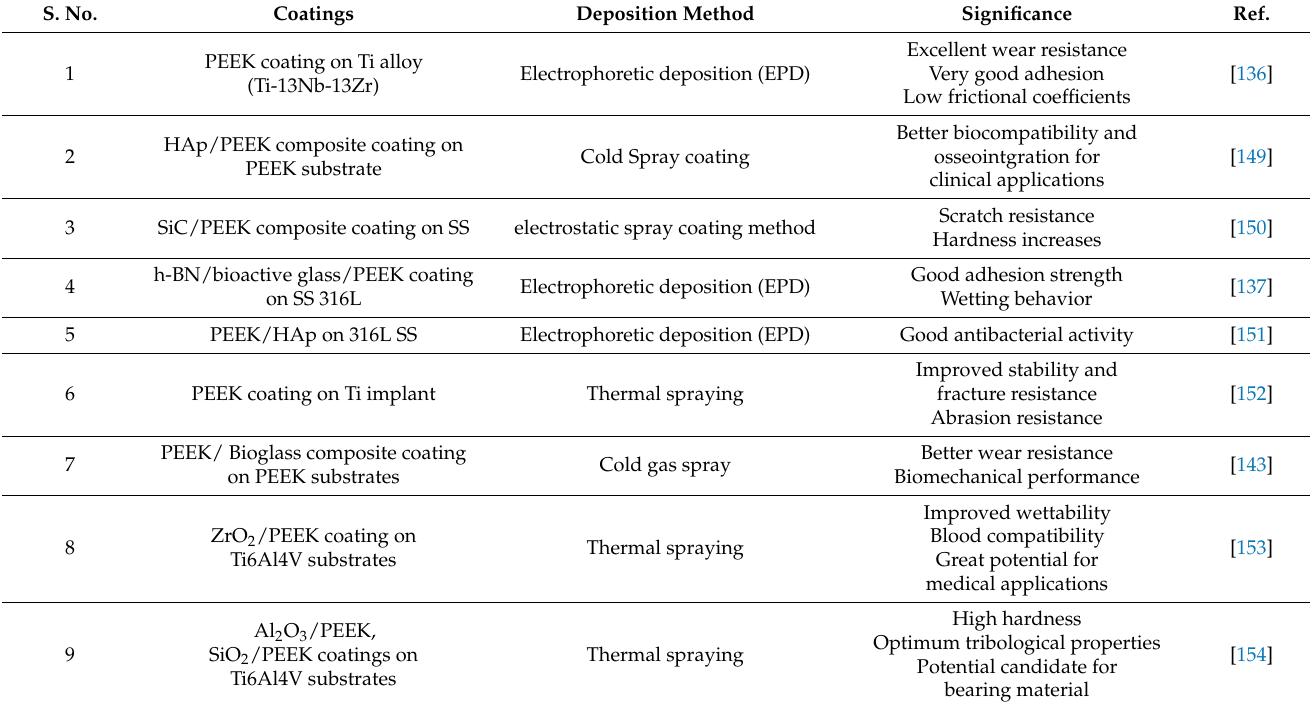
Table 3. Methods and properties of PEEK-based composite